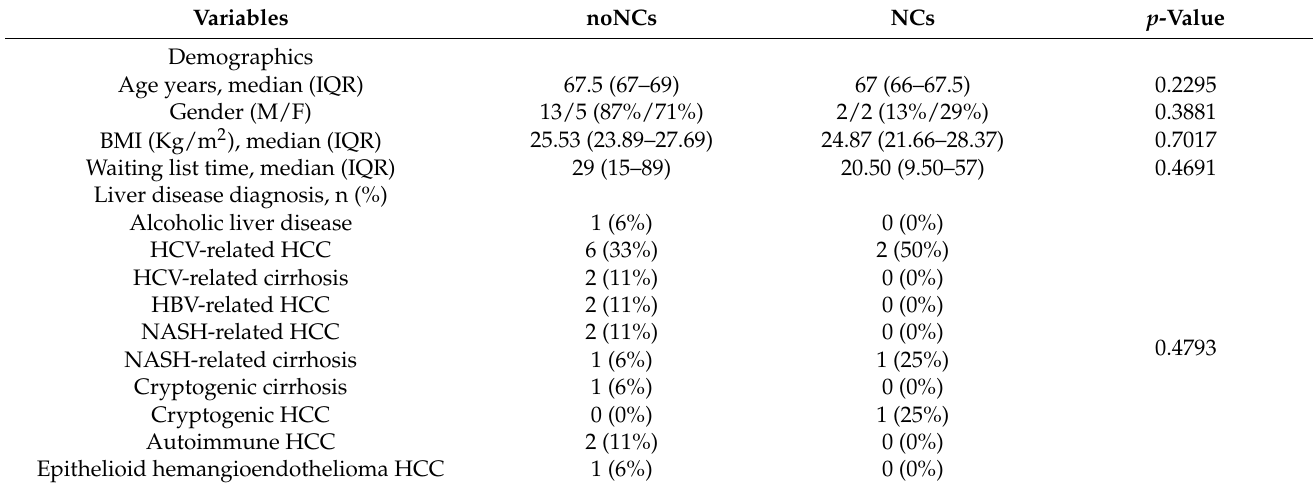
Table 4. Comparison of pre-operative risk factor profile in patients with post-operative acute NCs and patients without